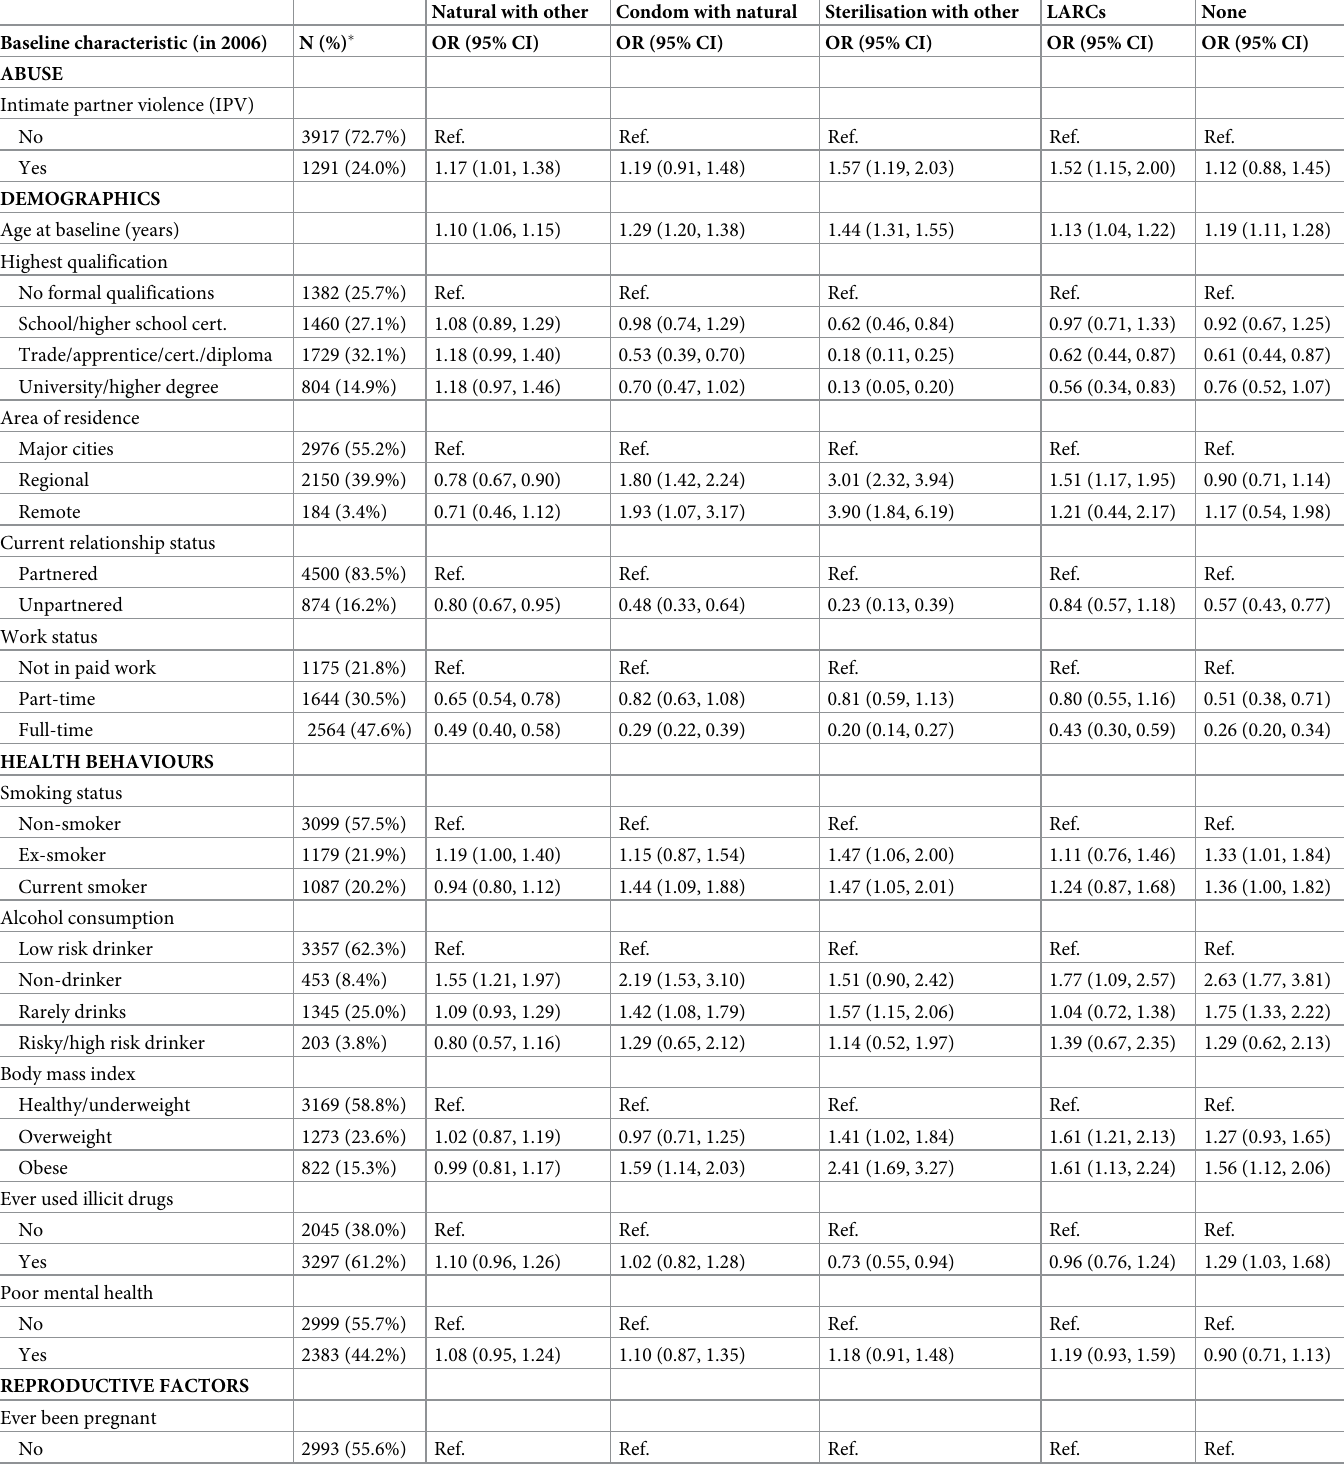
Natural with other Condom with natural Sterilisation with